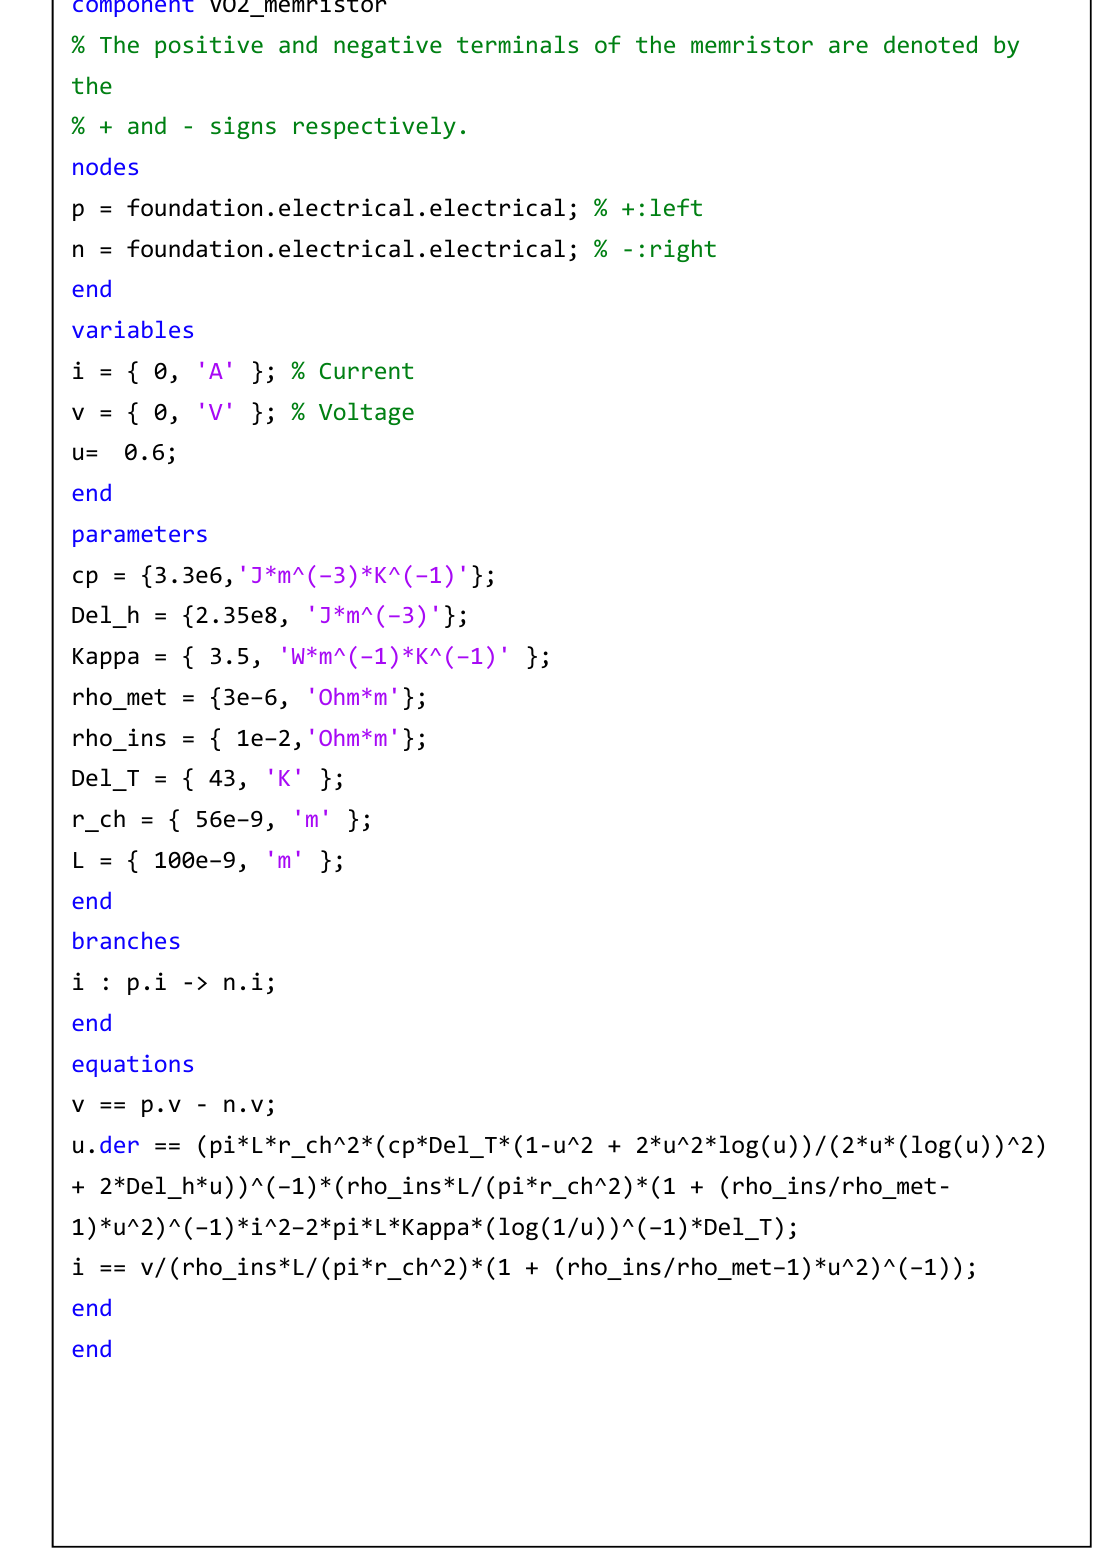
Figure 4. The script of the Simscape of Matlab.